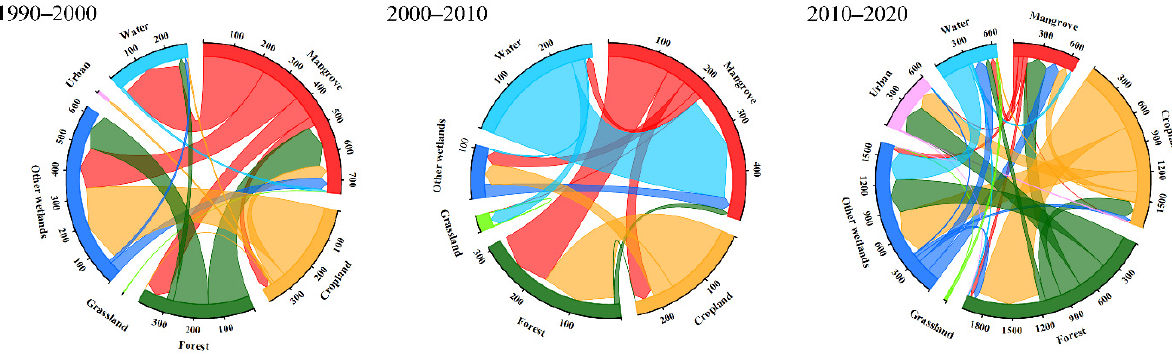
Figure 5. Transfer direction between the different land-use types in Dongzhaigang (( left ): 1990 − 2000, ( middle ): 2000 − 2010, ( right ): 2010 − 2020).